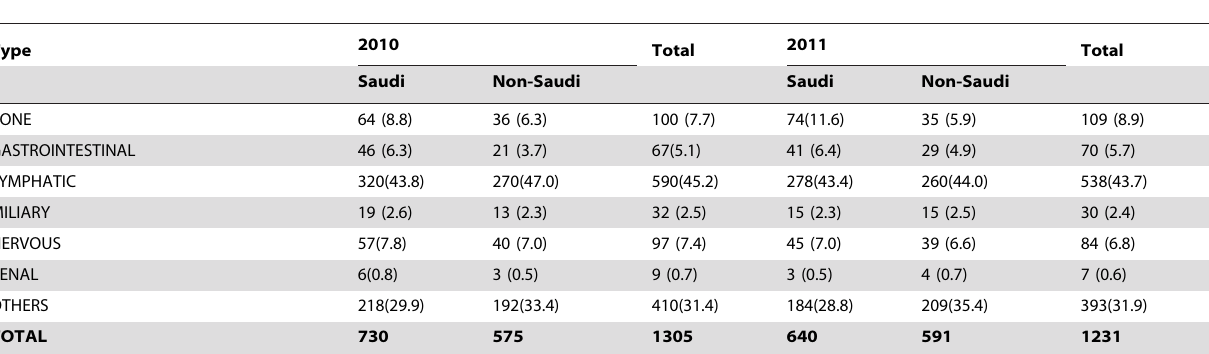
Table 2. The sites of new Extra-Pulmonary Tuberculosis patients in Saudi Arabia by nationality 2010–2011.